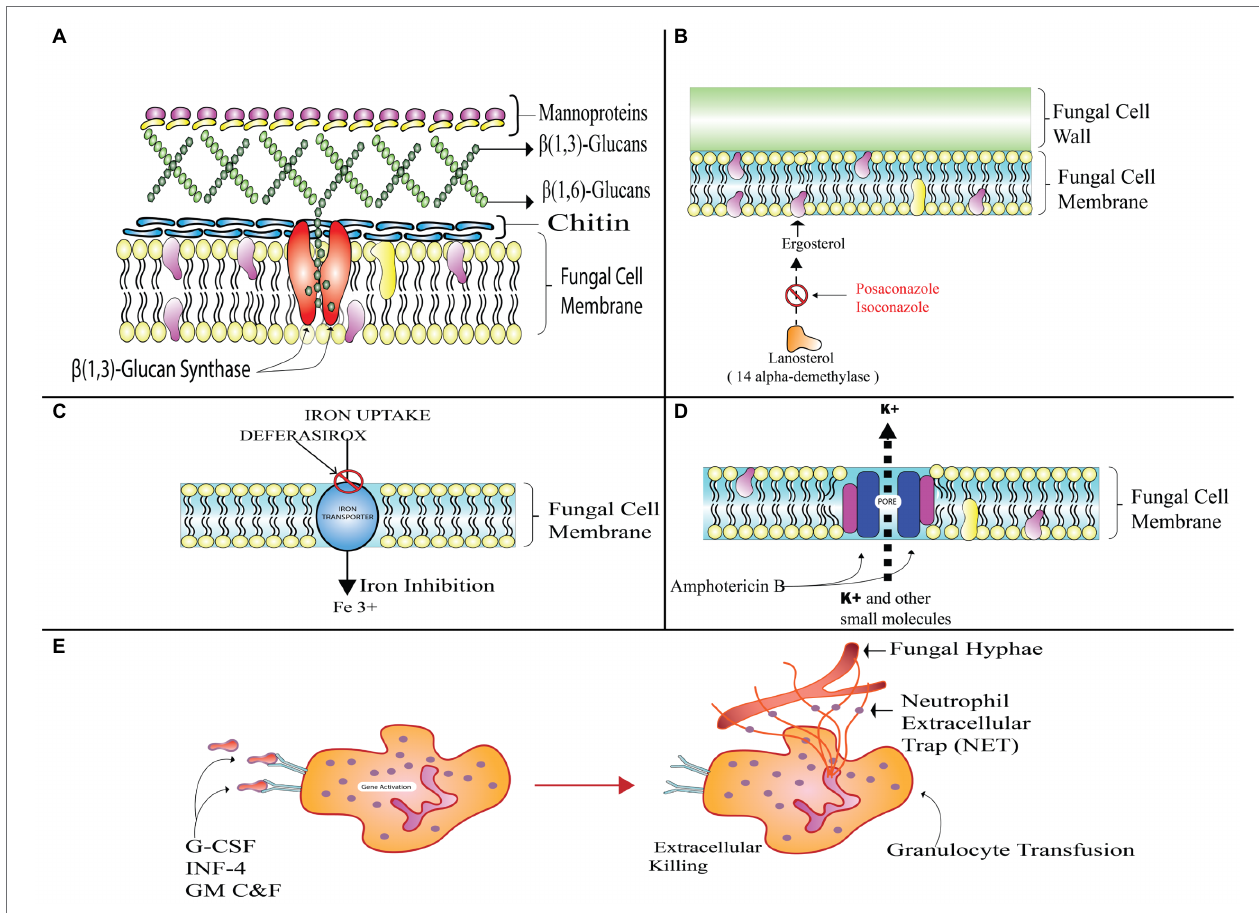
FIGURE 5 | Drugs used for treating mucormycosis- targets and modes of action. (A) Represents the pore formation on fungal membrane after binding of polyene with ergosterol; (B) Triazole mediated inhibition of ergosterol synthesis by inhibition of lanosterol 14-alpha- demethylase enzyme; (C) Echinocandins halt the beta- glucan linking of cell wall; and (D) Iron chelation therapy by deferasirox (DFS) inhibiting fungal uptake of iron. (E) Cytokine therapy activating granulocyte transfusion can aid treatment by damaging fungal